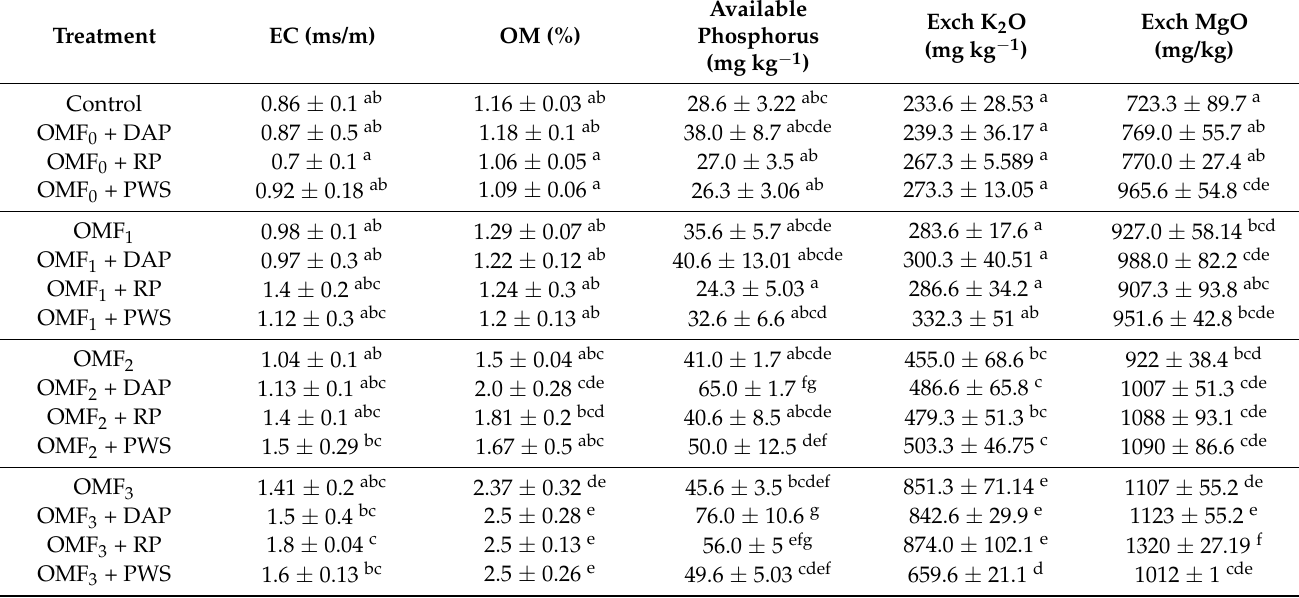
Table 3. Soil physicochemical properties after